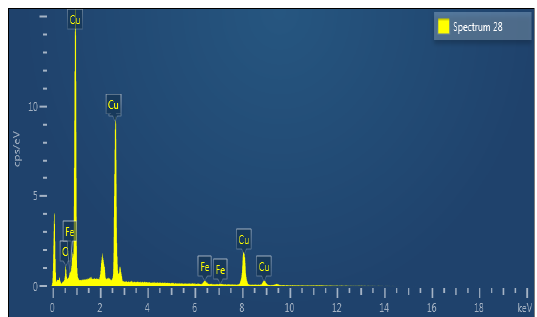
Figure 4. EDS spectrum of Fe-Cu material.